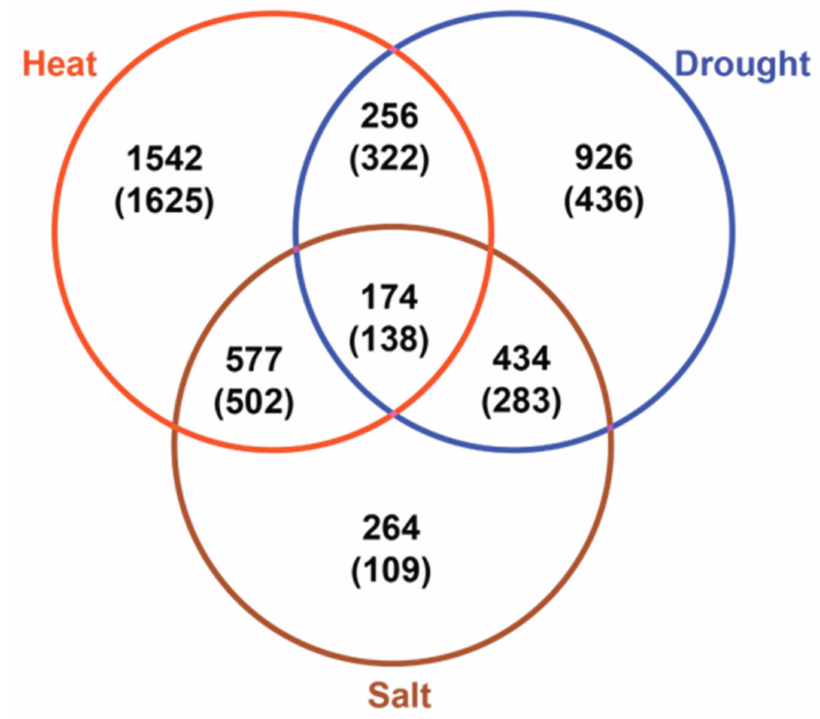
Figure 3. Overlap of genes differentially regulated in leaves of plants subjected to long-duration heat, drought, and salt stress. The Venn diagram shows the overlap of genes upregulated and down regulated (in parentheses) under long-term heat (red), drought (blue), and salt (brown) stress